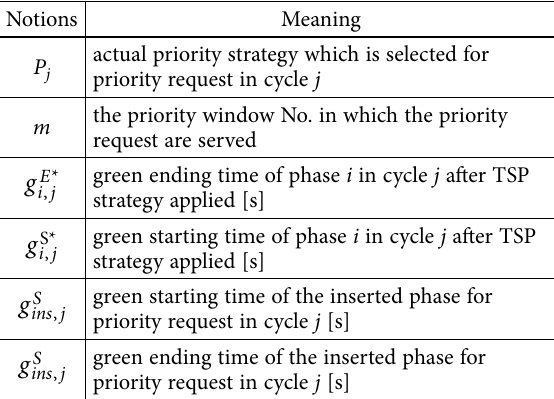
Table 2. Summary of decision